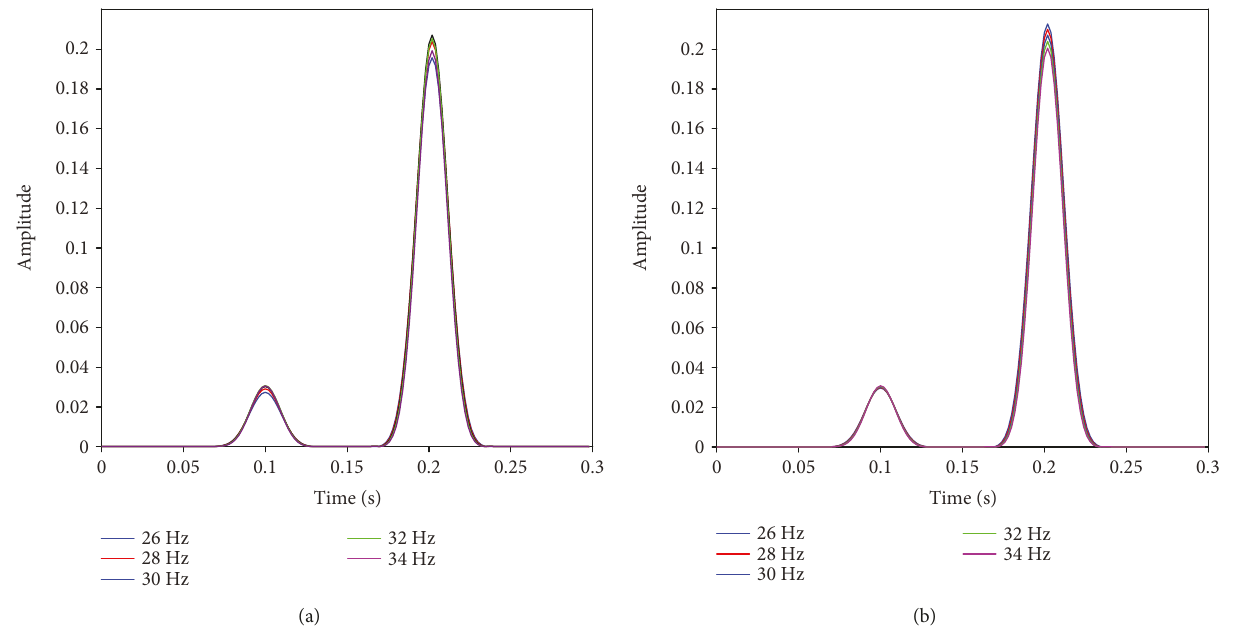
Figure 3: (a) Decomposed synthetic at 6 ° incidence for layered medium model by SPWVD. (b) The balanced results of the decomposed synthetic. The e ff ects of seismic wavelet at di ff erent frequency are eliminated by spectrum balance technique. The remaining energy di ff erences with various frequencies at 0.2s are caused by seismic dispersion.